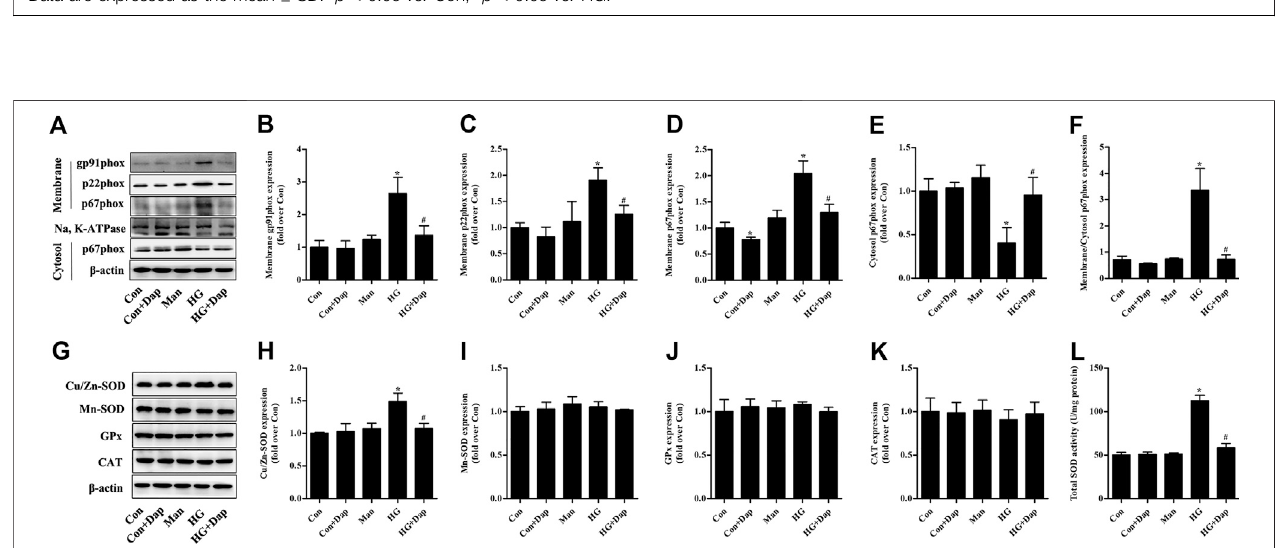
FIGURE 6 | Effectsof DAP on NADPH oxidases and antioxidant enzymes in high glucose-treated H9C2 cells. The treatment protocol ofH9C2 cells is the same as that in Figure 4 (A) Panel shows representativebands of NADPH oxidases. Histograms represent densitometry analysis of the membrane gp91phox (B) , p22phox (C) , andp67phox (D) protein,thecytosolp67phox (E) protein,andtheratioofp67phoxproteinexpressioninmembranetocytosol (F)(G) Panelshowsrepresentativebands ofantioxidantenzymes.Histogramsrepresentdensitometryanalysisofthecopper,zincsuperoxidedismutase(Cu/Zn-SOD, H ),manganesesuperoxidedismutase (Mn-SOD, I ), glutathione peroxidase (GPx, J ), catalase (CAT, K ) (L) Levels of total SOD activity were measured. n (cid:1) 3 – 4. Data are expressed as the mean ± SD. * p < 0.05 vs. Con; # p < 0.05 vs. HG.